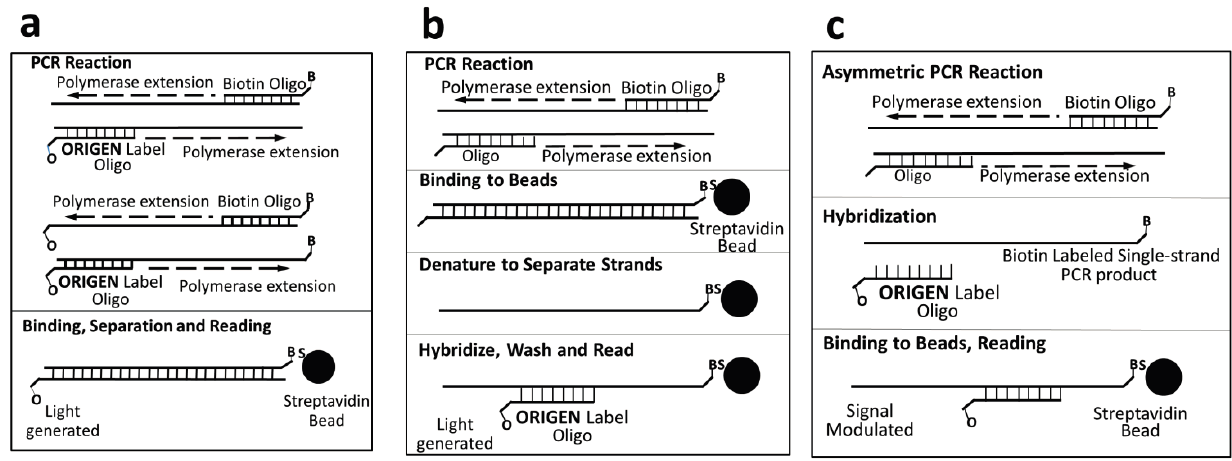
Figure 7. ECL detection of PCR products using Ru(bpy) 32+ conjugated DNA as probes. ( a ) direct incorporation PCR format with Origen-labeled oligonucleotides and biotin-labeled oligonucleotides as primers; ( b ) usual PCR format but with a biotinylated primer to allow the generation of biotinylated PCR product; ( c ) asymmetric PCR format, generating single-stranded biotinylated DNA for later hybridization to Origen-labeled oligonucleotides. Adapted from ref. [172], copyright (1991) American Association for Clinical